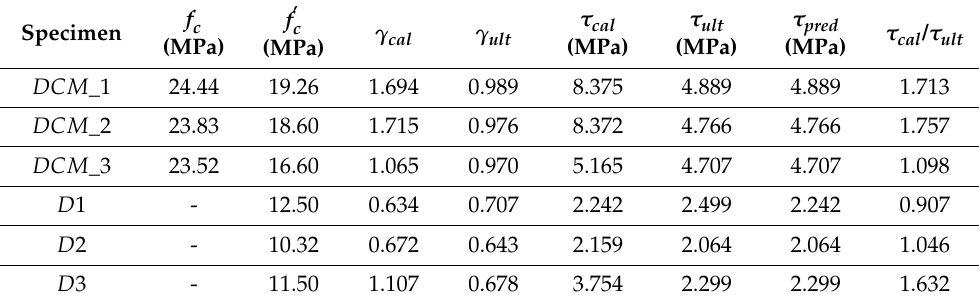
Table 4. Experimental and predicted values of concrete shear stress in the potential failure plane. Specimen